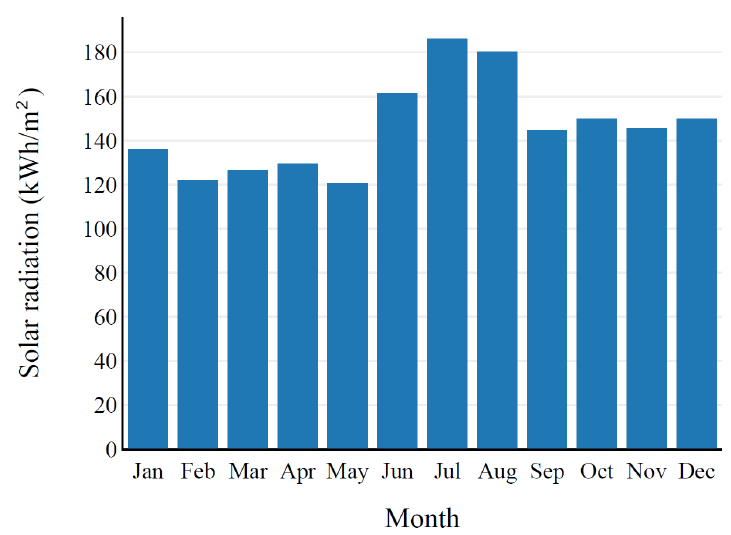
Figure 6. Monthly solar radiation for one year. Figure 7 is the daily average temperature for one year for a month. The average